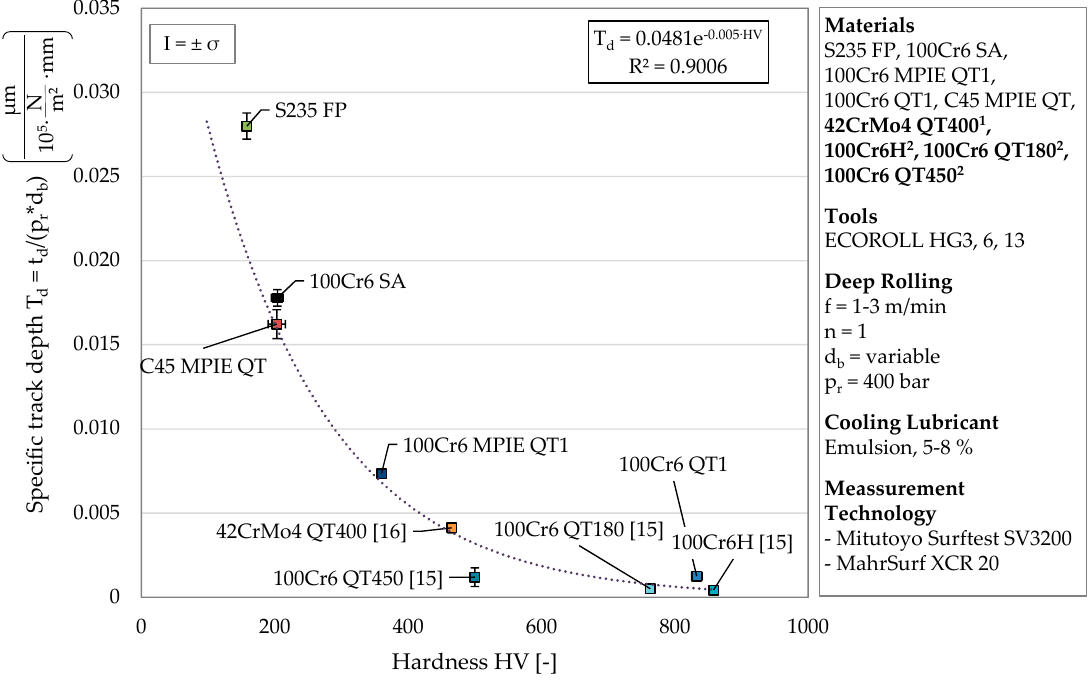
Figure 6. Development of the specific track depth T d with increasing hardness change ( 1 values according to [16], 2 depths corresponding to the track widths presented in [15]).